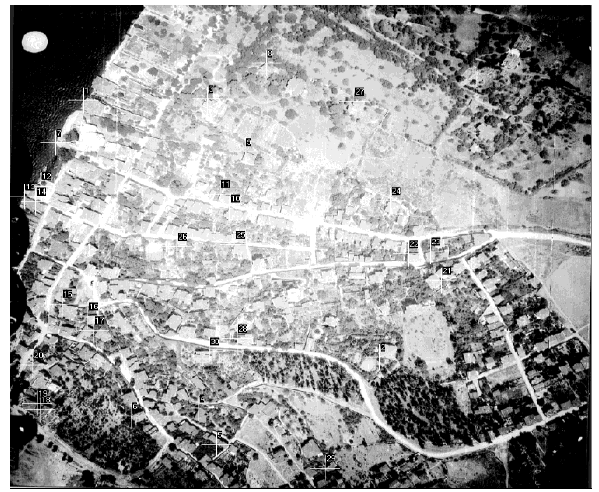
Figure 2. The distribution of the control points in the aerial photo